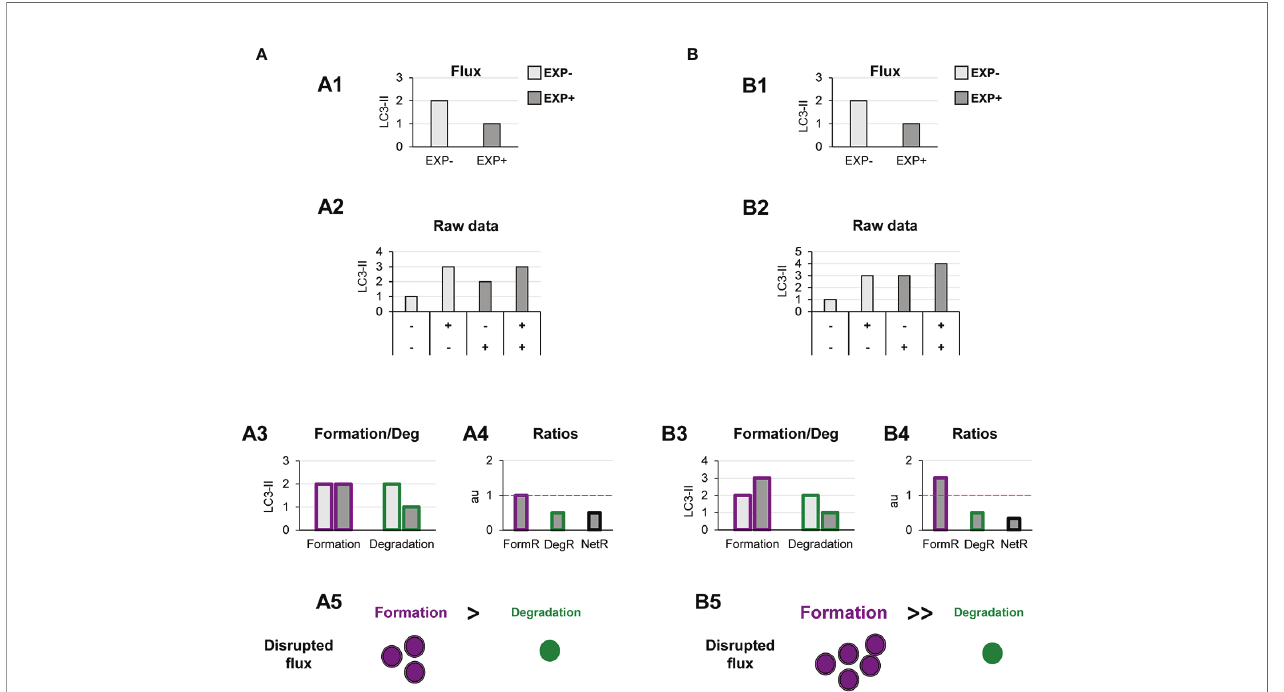
FIGURE 5 | Theoretical examples of decreased autophagosome degradation that lead to unbalanced autophagy. (A, B) show examples with similar conventional fl ux (A1, B1), derived from apparently similar raw LC3-II/actin Western blot data (A2, B2). In (A) our model would reveal a decreased autophagosome degradation rate and no changes in the formation rate (A3), leading to a reduced degradation ratio and net ratio (A4), and an unbalanced autophagy (A5). In contrast, in (B) our model would reveal increased autophagosome formation rate but decreased degradation (B3), leading to increased formation ratio, reduced degradation ratio, and a strong reduction in the net ratio (C4), ultimately resulting in a highly unbalanced autophagy